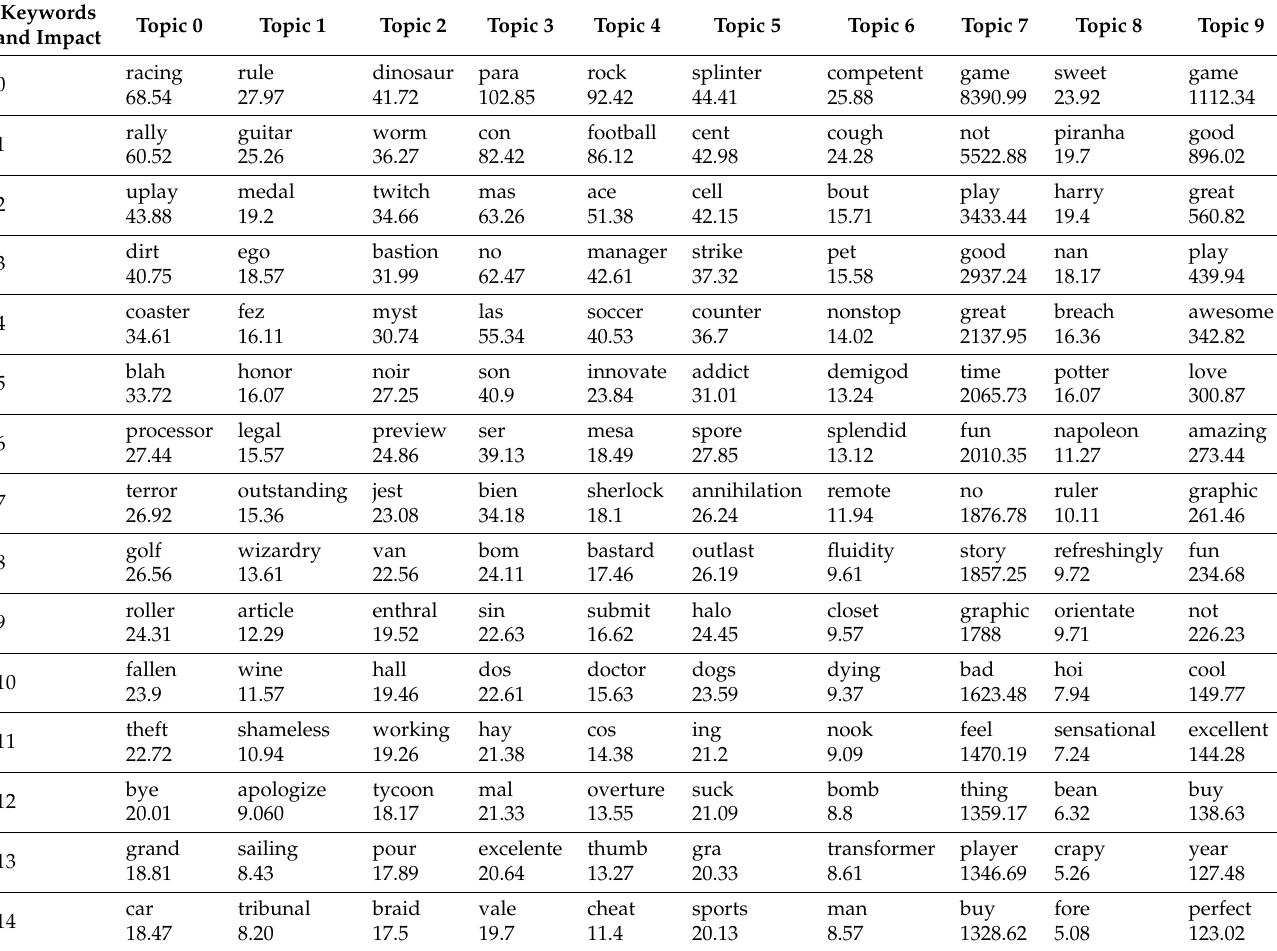
Table 3. The most relevant features for topics generated with